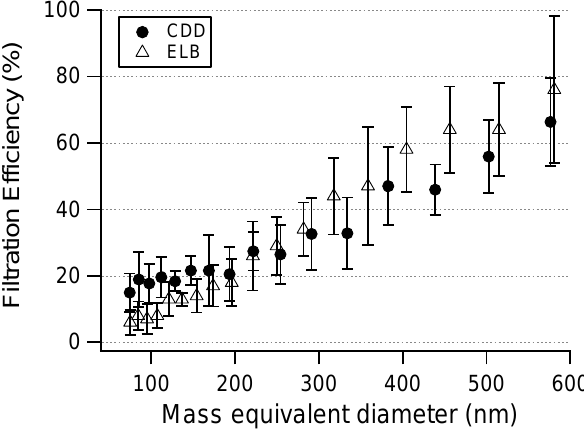
Figure 3. SP2-based filtration efficiency (FE) of rBC particles col- lected on quartz filter for CDD and ELB samples. The whiskers stand for one standard